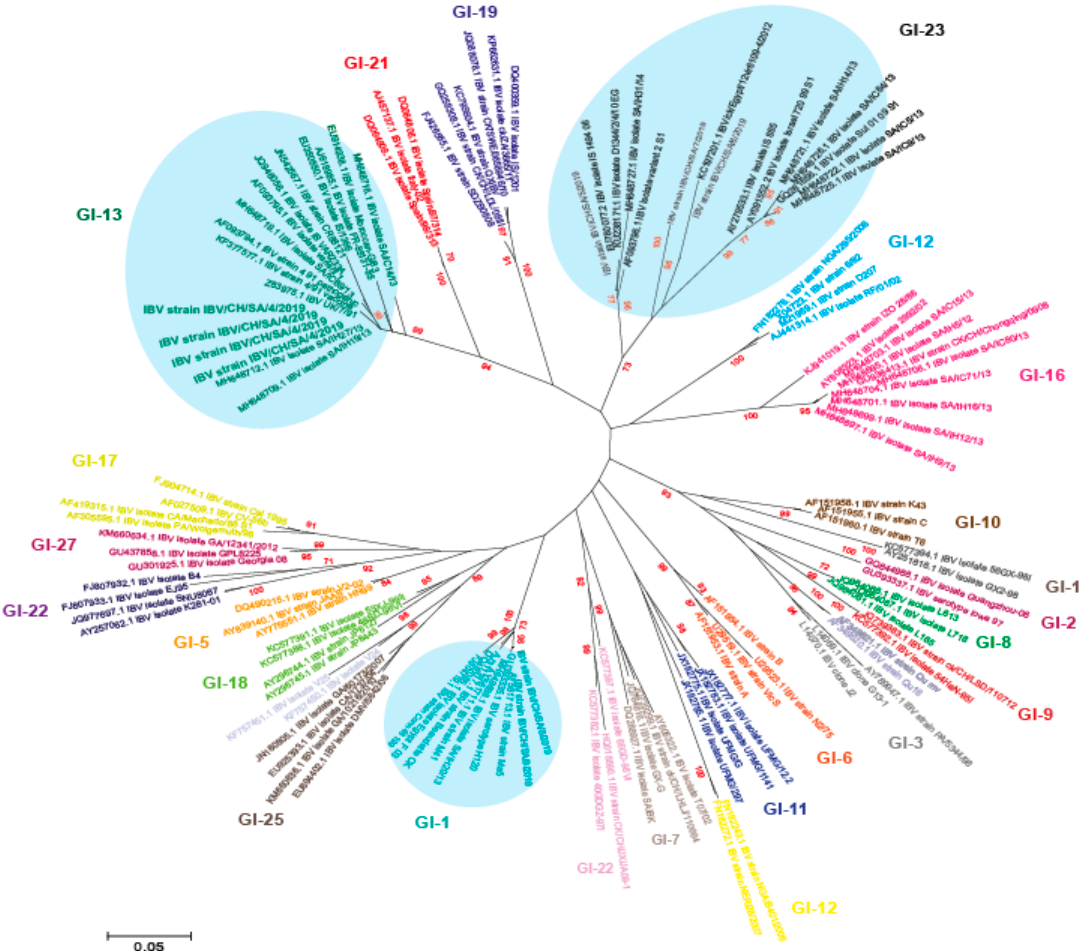
Figure 1. Phylogenetic analysis based on S1 gene of the newly identified infectious bronchitis viruses (IBVs) in Saudi Arabia during 2019 showed the clustering pattern for the studied isolates with different IBV lineages labelled with circle .